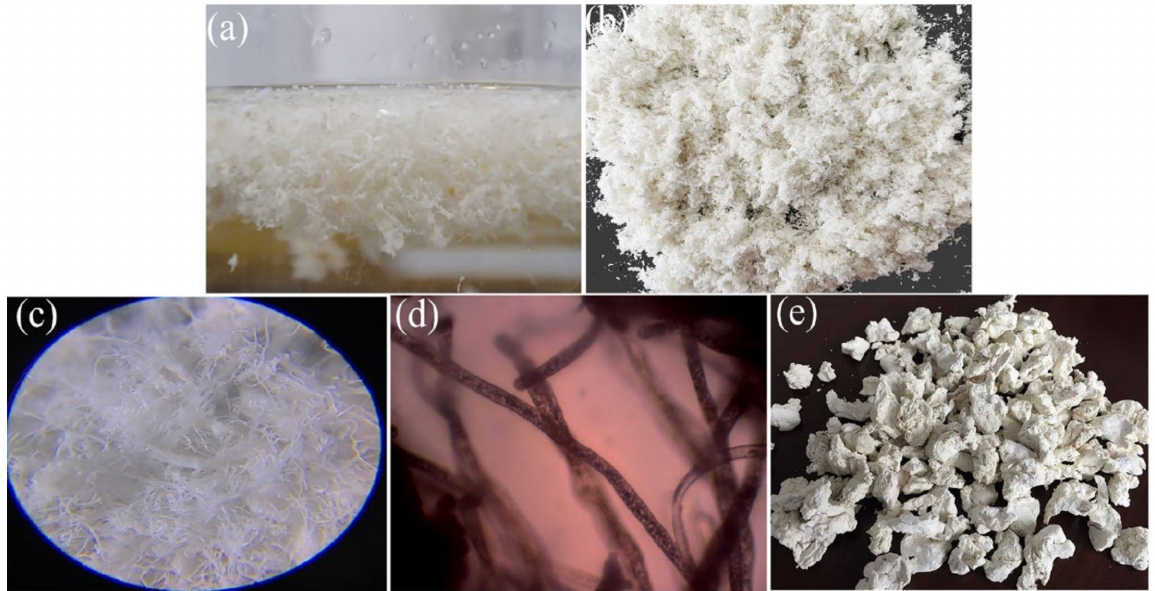
Figure 8. ( a ) gutta-percha dispersed in water, ( b ) gutta-percha after drying, ( c ) optical micrograph of gutta-percha × 100, ( d ) optical micrograph of gutta-percha × 400, ( e ) gutta-percha obtained by petroleum ether